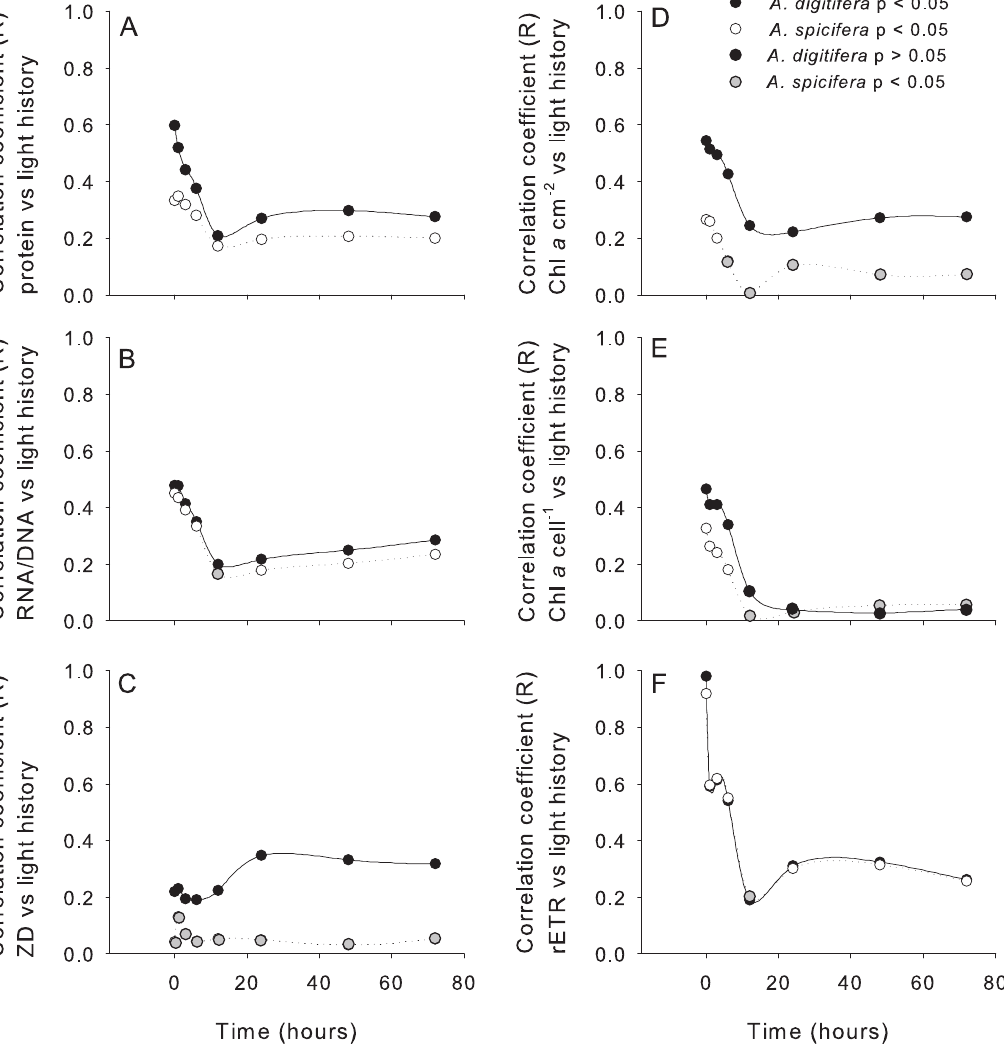
Figure 3. Correlation coefficient (R) between health indices and light history. Determined for A) protein concentration (mg mgDNA-1), B) RNA/DNA ratio, C) zooxanthellae density (cells cm 2 2 ), D) Chlorophyll a per surface area (mg cm 2 2 ), E) Chlorophyll a per cell (mg cell-1) and F) relative electron transport rate (rETR) (Based on DISTLm).